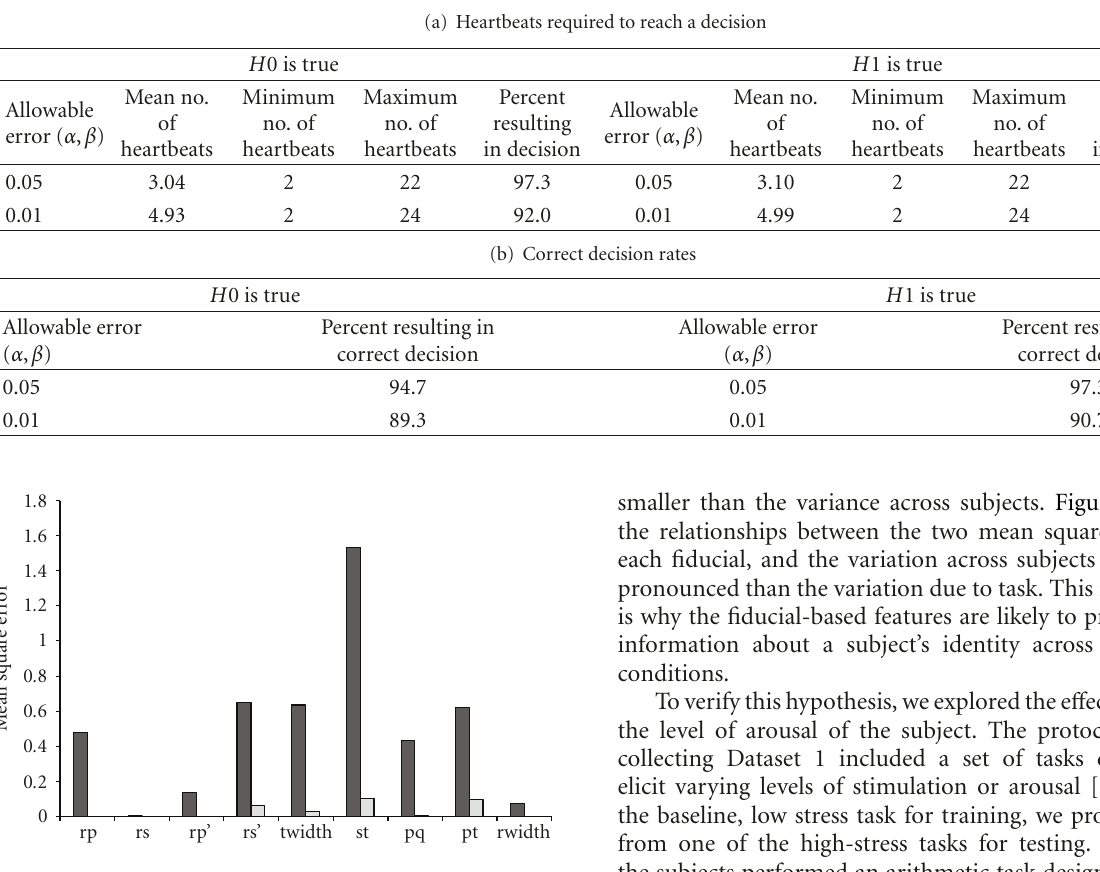
Table 2: Analysis of second data set.